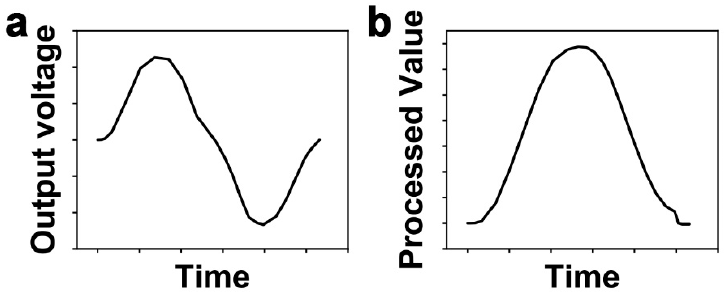
Figure 4. Schematic diagram of an example of a sensor signal when a force is applied and released. ( a ) Output voltage of a single sensor. ( b ) Processed value from the output voltage of a single sensor.